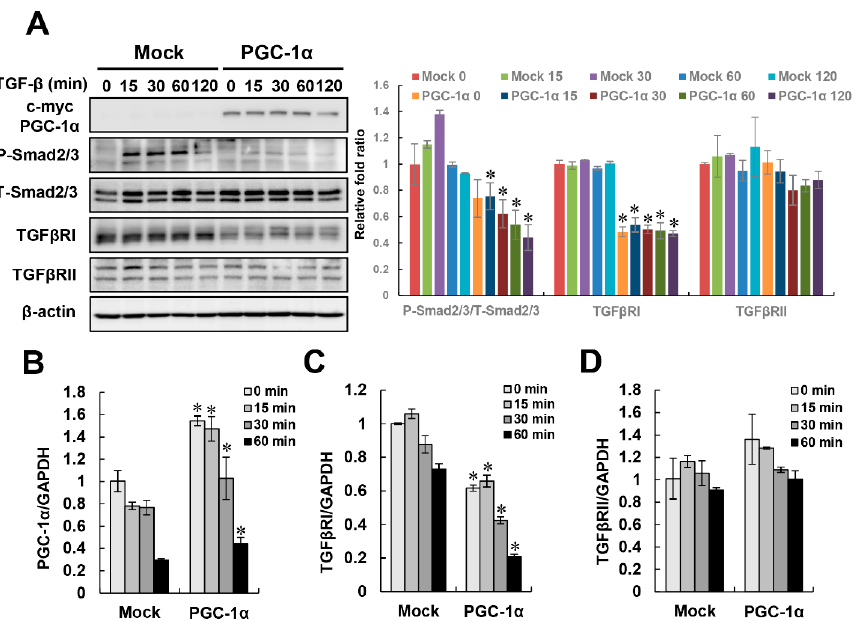
Figure 4. Inactivation of TGF β /Smad signaling by PGC-1 α . To identify signaling pathways related to the protective effect of PGC-1 α on EMT, the regulation of canonical TGF- β /Smad signaling at the protein ( A ) or mRNA ( B–D ) levels was assessed in mock and PGC-1 α cells at the indicated times (0, 15, 30, 60, and 120 min for protein levels or 0, 15, 30, and 60 min for mRNA levels) after TGF- β treatment. Protein expression and the activation of canonical TGF- β /Smad signaling components were analyzed by measuring Smad2 phosphorylation at Ser465/467 and Smad3 phosphorylation at Ser423/425. Total expression levels of Smad2/3, TGF β RI, and TGF β RII were evaluated with anti- Smad2/3, anti-TGF β RI, and TGF β RII antibodies, respectively. Bar graphs show mean ratios of the phosphorylated to total forms of Smad2/3, TGF β RI, and TGF β RII/ β -actin, as measured by densitometry. The mRNA levels of PGC-1 α , TGF β RI, and TGF β RII were analyzed by real-time PCR. Bar graphs show mean ratios of the indicated targets (PGC-1 α , TGF β RI, and TGF β RII) to GAPDH, which was used as an internal reference. * p < 0.05, mock cells vs. PGC-1 α cells at the indicated time.